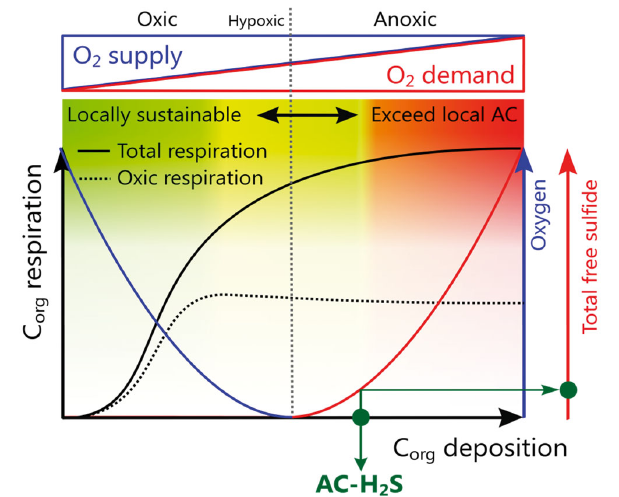
Fig. 1. Conceptual representation of assimilative capacity (AC-H 2 S) of organic-rich solid wastes in sediments underly- ing fish farm cages. Total and oxic respiration are repre- sented by black solid and dashed lines, respectively, while O 2 and total S 2− concentrations are represented by blue and red lines, respectively. The green circles represent the high- est C org loading rate (particulate organic carbon + organic wastes, net value) feasible to be assimilated by benthic communities while preventing toxic sulfide concentration to rise above the regulatory limit in